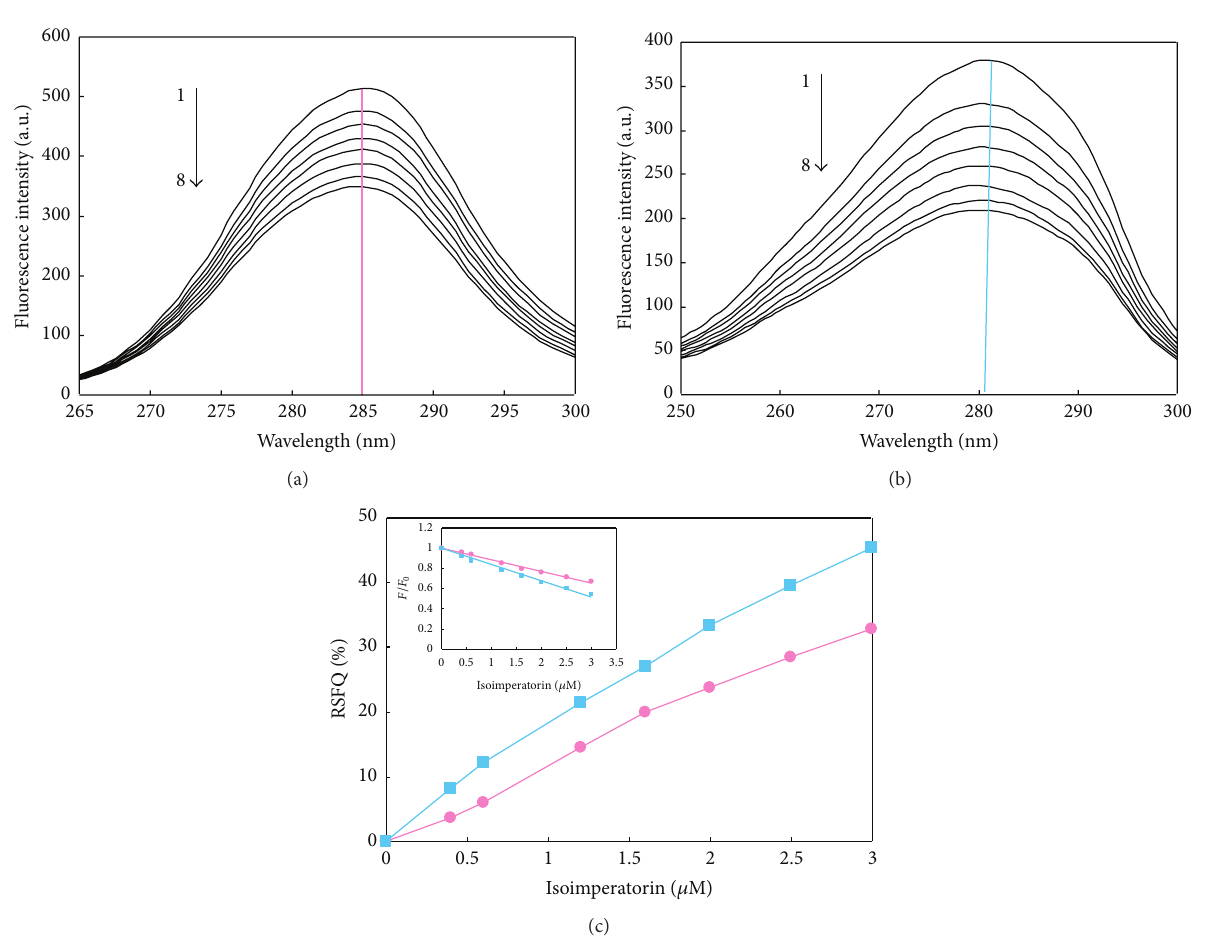
Figure 9: Synchronous fluorescence spectra of interaction between HSA and isoimperatorin (a) at Δ𝜆 = 15 nm and (b) at Δ𝜆 = 60 nm. ConcentrationofHSAwas3.0 𝜇 M,whileconcentrationsofisoimperatorinwere0,0.4,0.8,1.2,1.6,2,2.5,and3 𝜇 Mfrom1to8.(c)Comparative evaluation of isoimperatorin effect on the RSFQ of HSA; [ HSA ] = 3𝜇 M, ( ◼ ) Δ𝜆 = 15 nm, and ( ∙ ) Δ𝜆 = 60